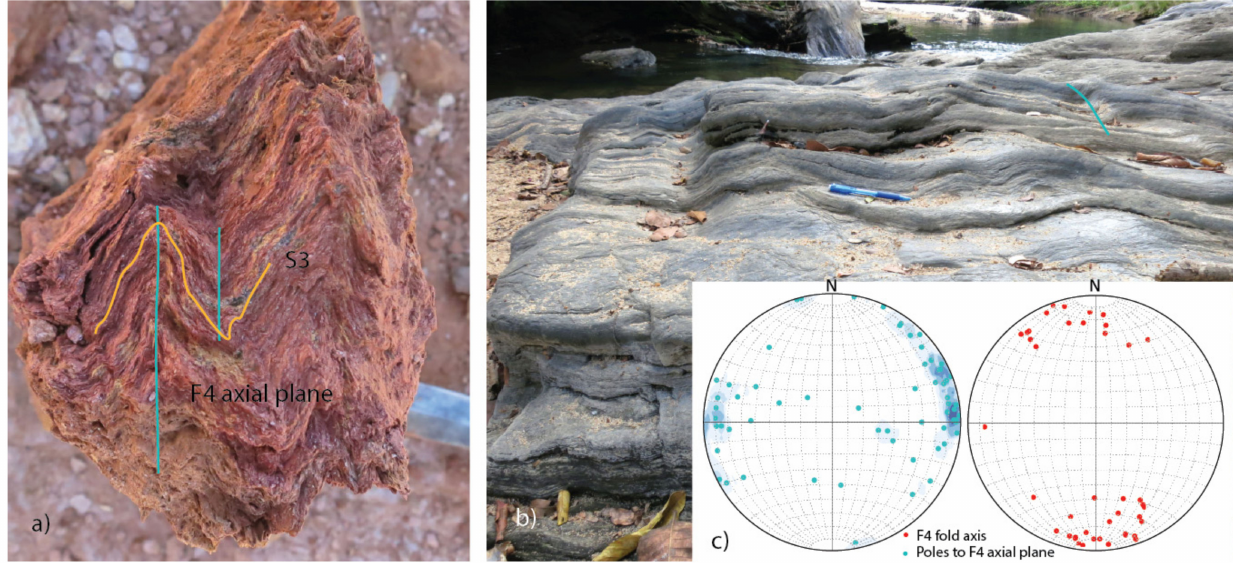
Figure 8. Structures related to the D3 and D4 deformation events. ( a ) Upright F4 kink folding of volcano-sedimentary rocks of the Neoproterozoic Mara Rosa Magmatic arc. ( b ) Upright F4 folding of bedding in a meta-turbiditic sequence of the C ó rrego Geral Fm. ( c ) Stereoplots show the distribution of poles to F4 kink fold axial plane and F4 fold